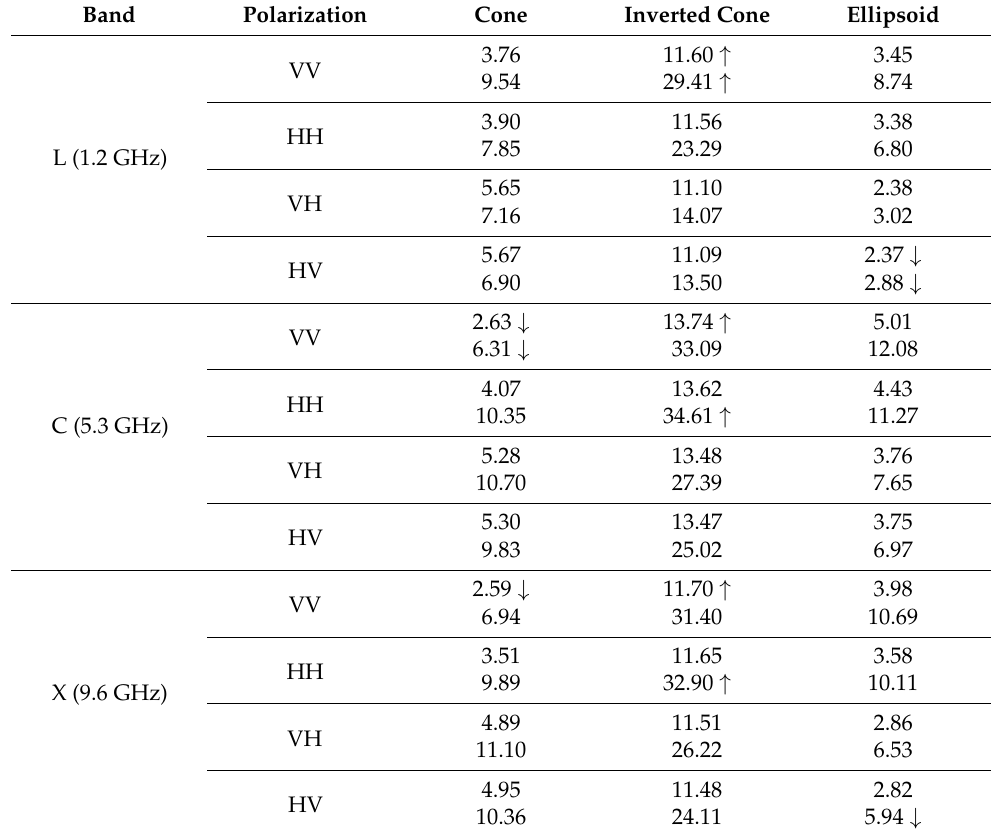
Table 5. µ a and µ r of the simulation results between the three crown shapes studied and the reference cylinder crown shape when using canopy B’s parameters as inputs. Band Polarization Cone Inverted Cone